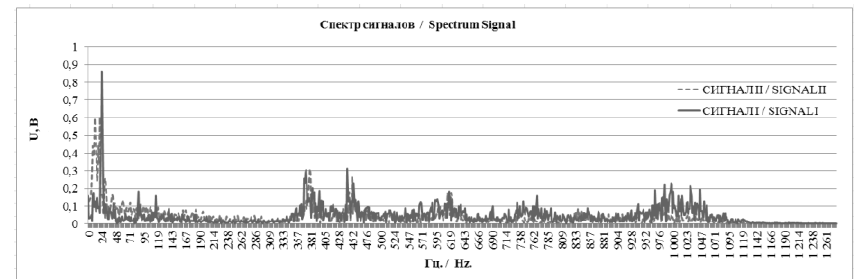
Fig. 8. Spectral representations of signals I and signals